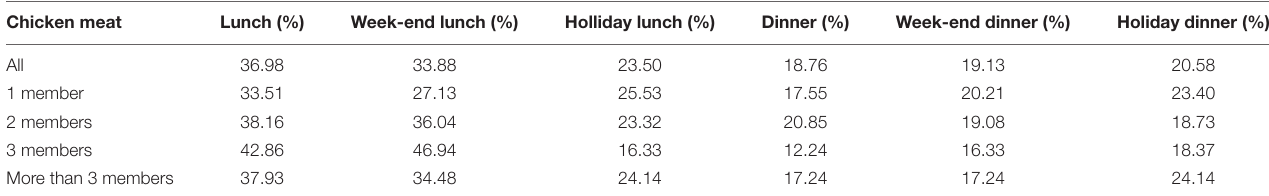
TABLE 5 | The structure of the change in the chicken consumption depends on the festive or ordinary moment of the day and (depending on) the members that contribute to the family